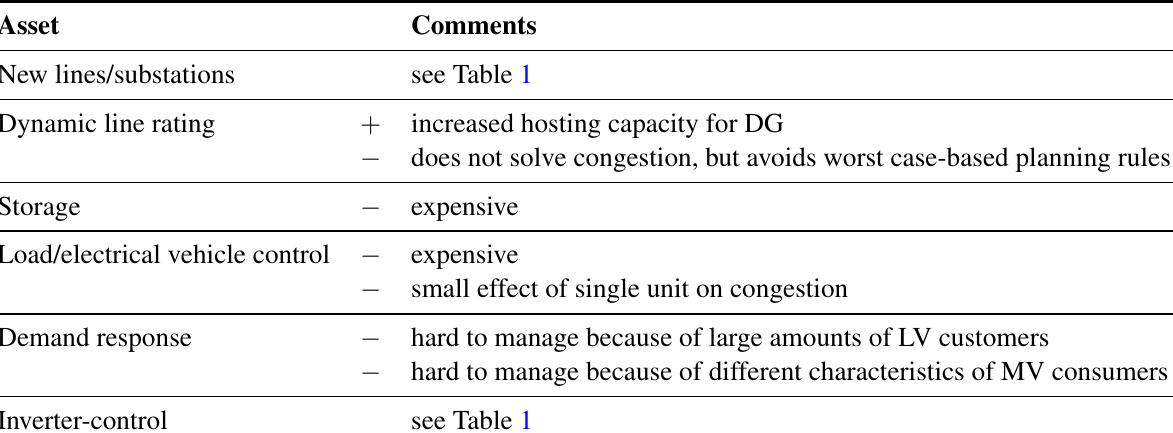
Table 2. Solutions for current congestion